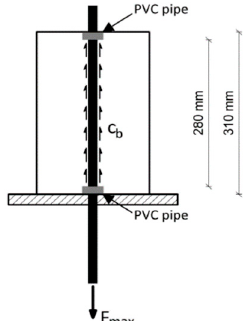
Figure 7. Distribution of bond strength in embedded length—simplification of constant average bond stress.